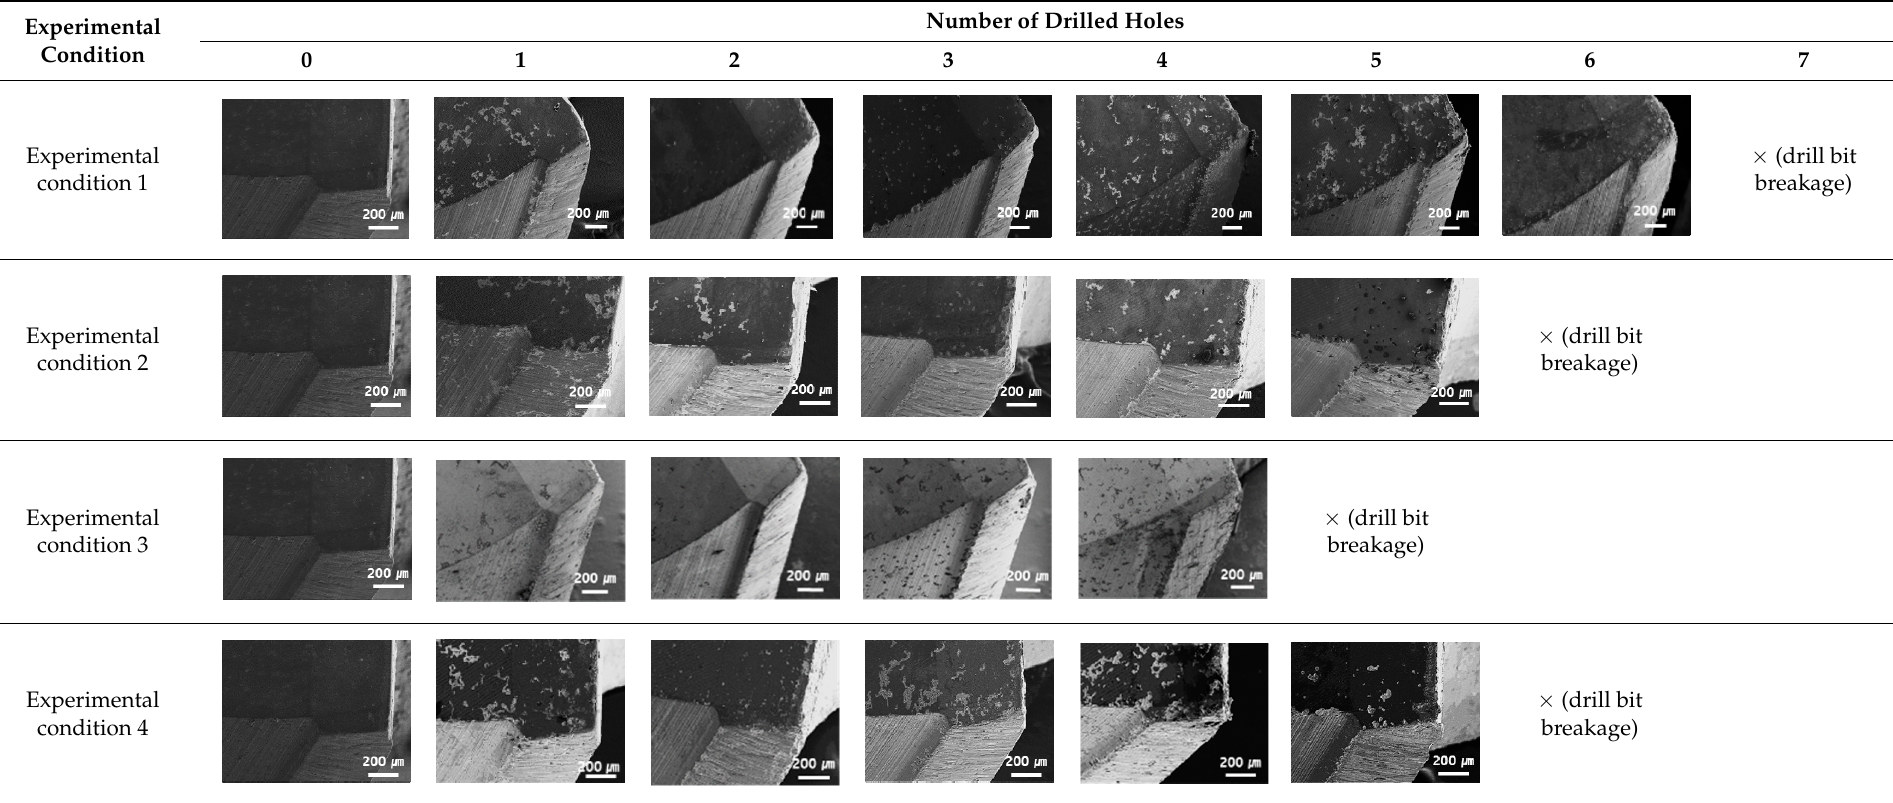
Table 5. Scanning electron micrographs of the outer corner of the drill bit for different numbers of drilled holes and experimental conditions.